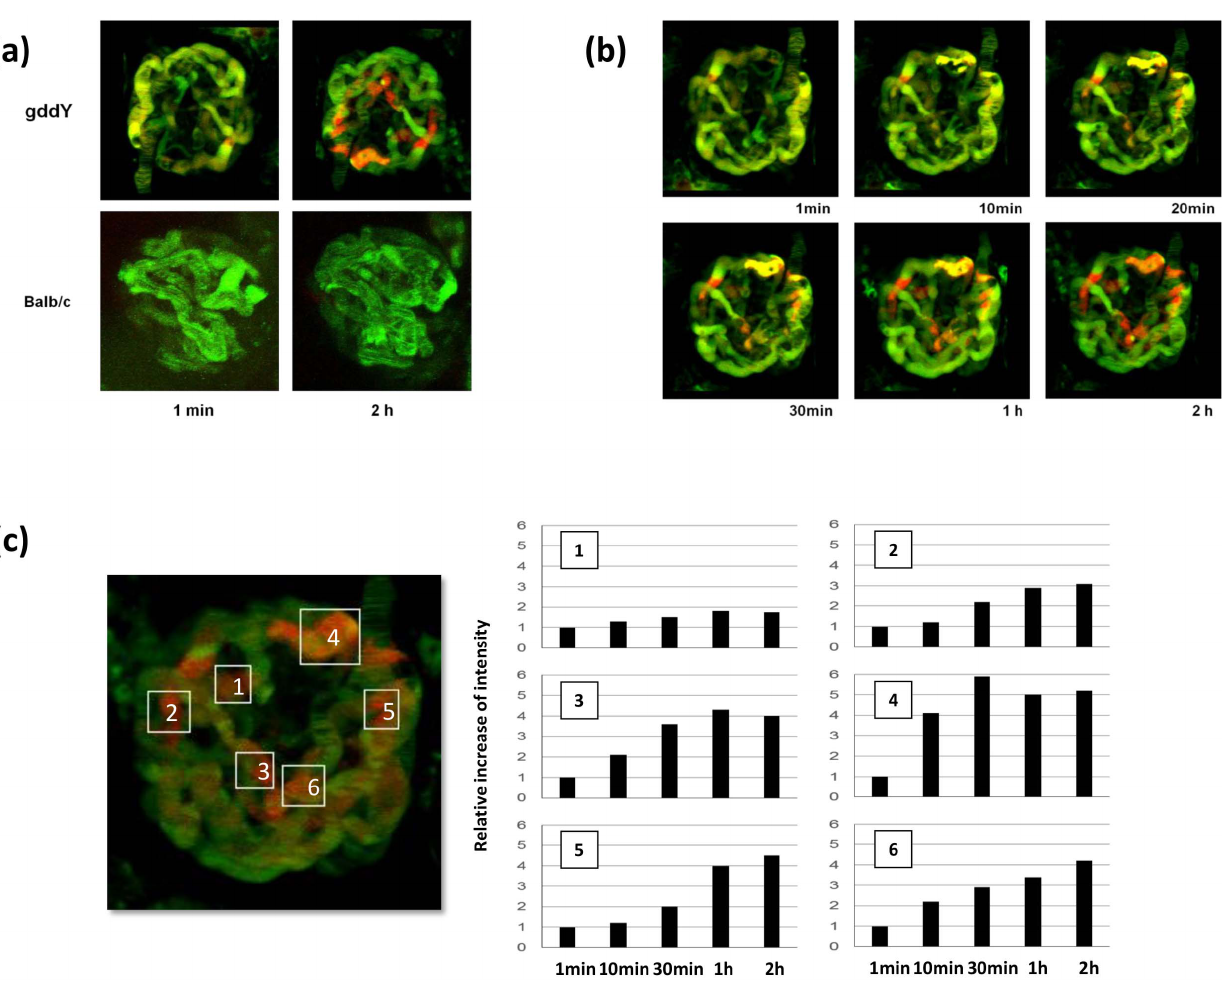
Figure 3. IgA from gddY mice is deposited along the glomerular capillary wall in a focal and segmental manner. Detailed kinetics of IgA deposition analyzed from 1 min to 2 h postinjection using confocal laser microscopy. Alexa Fluor 633-labeled IgA from gddY and Balb/c mice (red) and 500-kDa fluorescein-labeled dextran (green) were injected for analyzing kinetics of IgA deposition and visualizing blood vessel wall integrity, respectively. (a) IgA signals were detectable even after 1 min and accumulated up to 2 h in a focal and segmental manner in mice with IgA from gddY mice. In contrast, mice who received Balb/c IgA did not show a signal even after 2 h. (b)(c) Serial images of a glomerulus in mice with IgA from gddY mice showed that these IgA molecules accumulated on top of the initial aggregates along the glomerular capillaries. These aggregates were found in a focal and segmental manner but not in a diffuse and global manner.